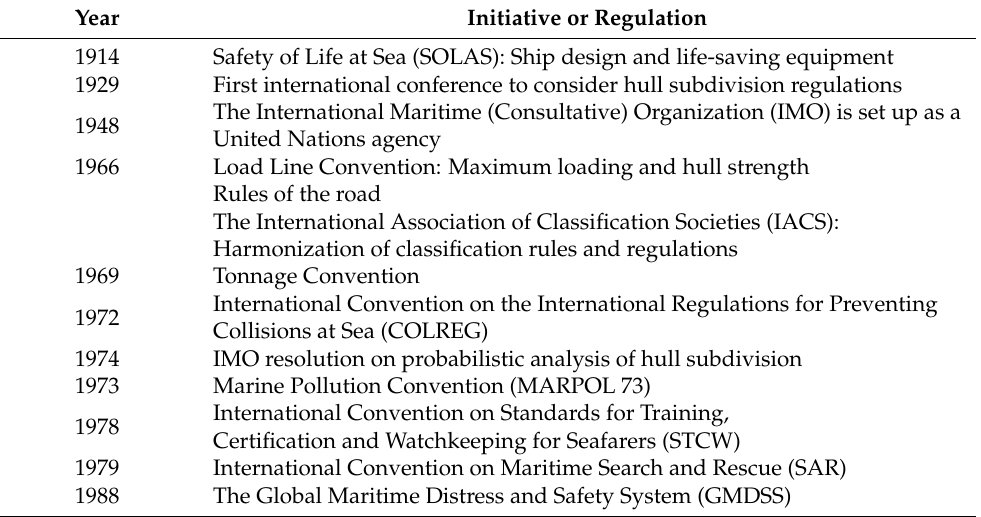
Table 1. Milestones in international maritime safety